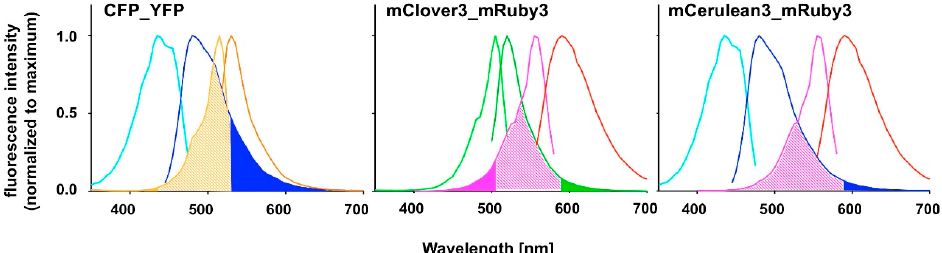
Figure 1. Excitation and emission spectra of fluorescent proteins presently or perspectively used as Förster resonance energy transfer (FRET) pairs. Spectra were recorded in the present study as described under Material and Methods. Spectra for CFP (light and dark blue lines), YFP (light and dark orange lines), mClover3 (light and dark green lines), mRuby3 (pink and red lines) and mCerulean3 (light and dark blue lines) are normalized to their respective maximum intensity. Overlap of donor emission spectra and acceptor excitation spectra are indicated by pale shading. Potential bleed-through problems due to donor emission (dark blue or dark green) or direct acceptor excitation (orange or pink) in the FRET channel are pointed out by color filling of the areas under the respective curves.